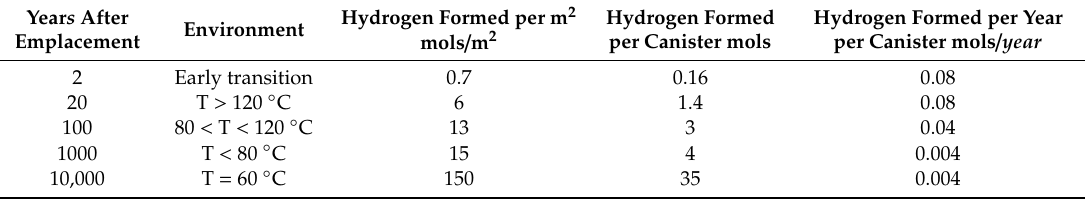
Table 6. Hydrogen gas generation per zone per canister of Alloy 625.